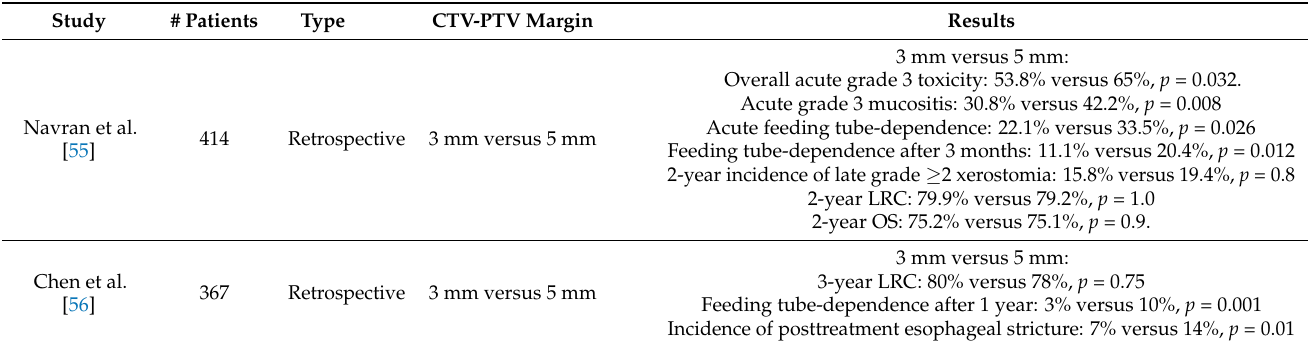
Table 5. Retrospective comparisons analyzing different CTV-PTV margin concepts. CTV = clinical target volume, PTV = planning target volume, LRC = locoregional control, OS = overall survival. Study # Patients